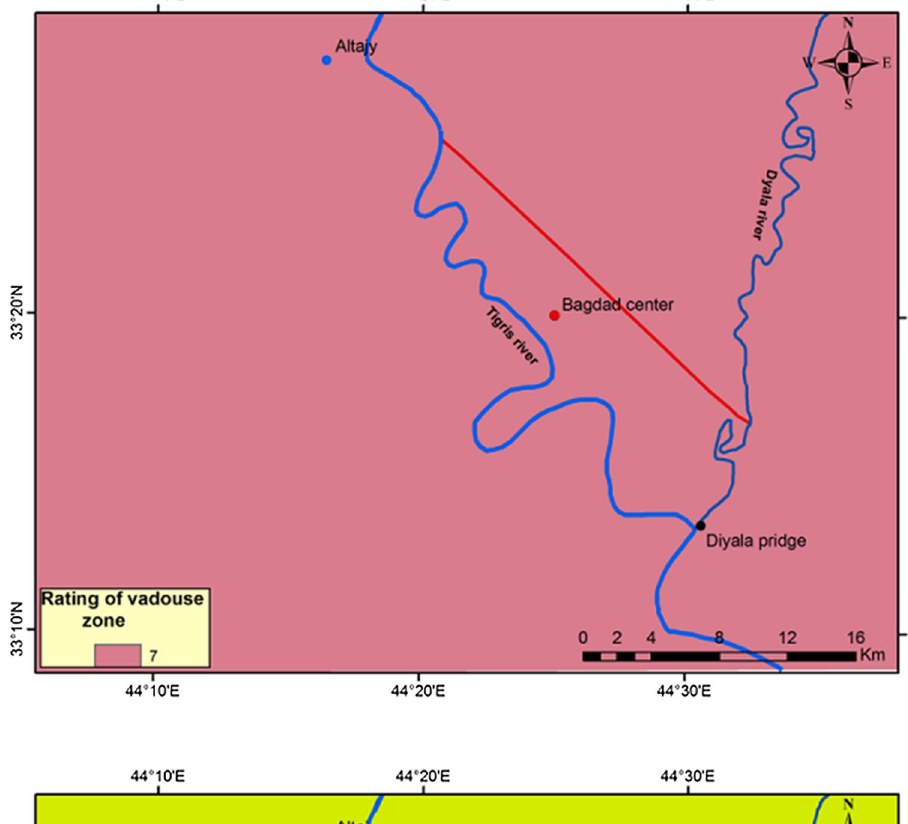
Fig. 12 Rating of hydraulic con- ductivity map of the study